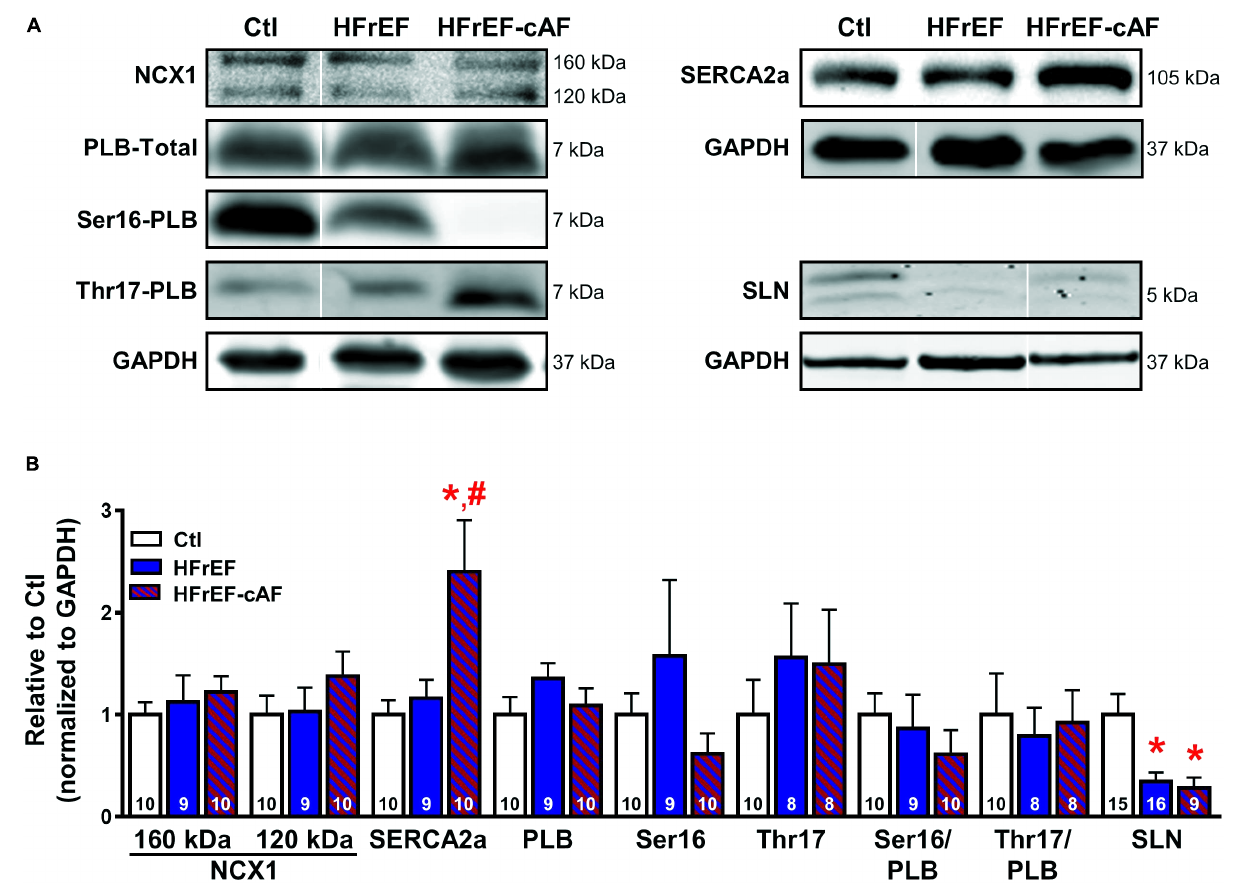
FIGURE 6 | Molecular determinants of increased sarcoplasmic reticulum (SR) Ca 2 + load. (A) Representative Western blot examples of protein expression of Na + -Ca 2 + -exchanger type-1 (NCX1; full-length protein of 160 kDa with proteolytic fragment at 120 kDa), SR Ca 2 + -ATPase type-2a (SERCA2a) and its inhibitory regulators phospholamban (PLB; total PLB as well as Ser16- and Thr17-phosphorylated PLB) and sarcolipin (SLN). GAPDH was used as loading control. Ser16-PLB of HFrEF-cAF represents an extreme example. (B) Quantification of NCX1, SERCA2a, total PLB, Ser16- and Thr17-phosphorylated PLB, Ser16/total PLB, Thr17/total PLB, and SLN in right-atrial tissue homogenates of Ctl (white bars), HFrEF (blue bars) or HFrEF-cAF (red/blue-striped bars). Numbers in bars indicate number of patients. ∗ indicates P < 0.05 vs. Ctl, # indicates P < 0.05 vs.